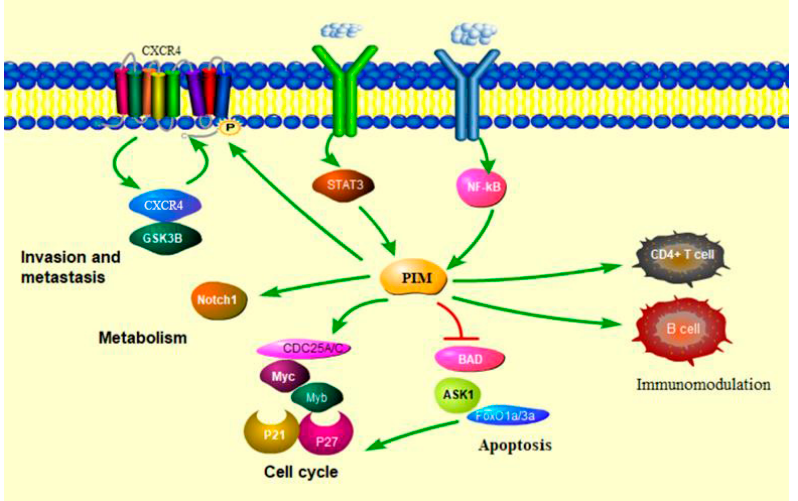
Figure 1. The regulation effect of PIM kinases in cancer. PIM kinase regulates many tumoral pathways by phosphorylating several target proteins, thereby activating or inactivating proteins involved in cell cycle progression, apoptosis, migration, or metabolism. PIM kinases promote the proliferation and survival of CD4+ T cells and B cells.